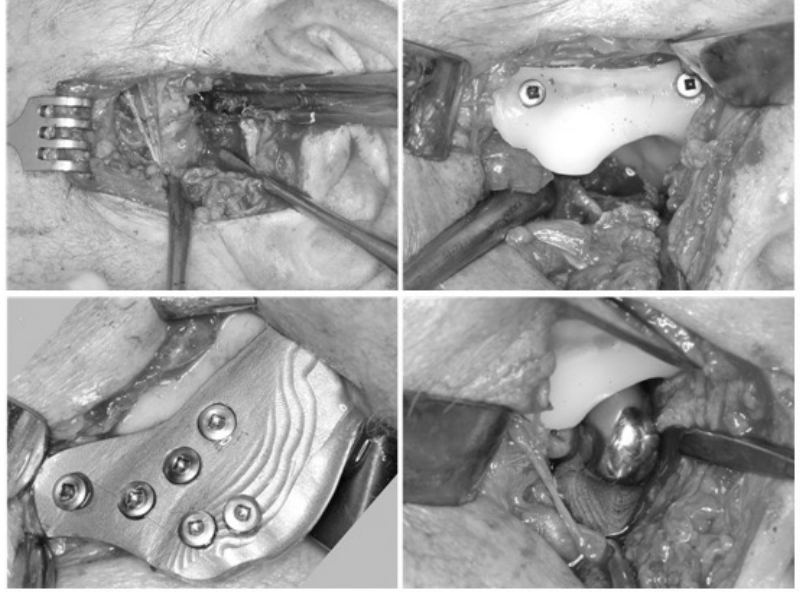
Figure 3. First operation of the patient—alloplasty of the TMJ. An individual prosthesis was prefabricated (the mandib ‐ ular fossa was made of UHMW ‐ PE and the condylar part was made of titanium). Glenoid fossa, discus, condyle process as well as part of the mandible ramus and part of pterygoid muscle were